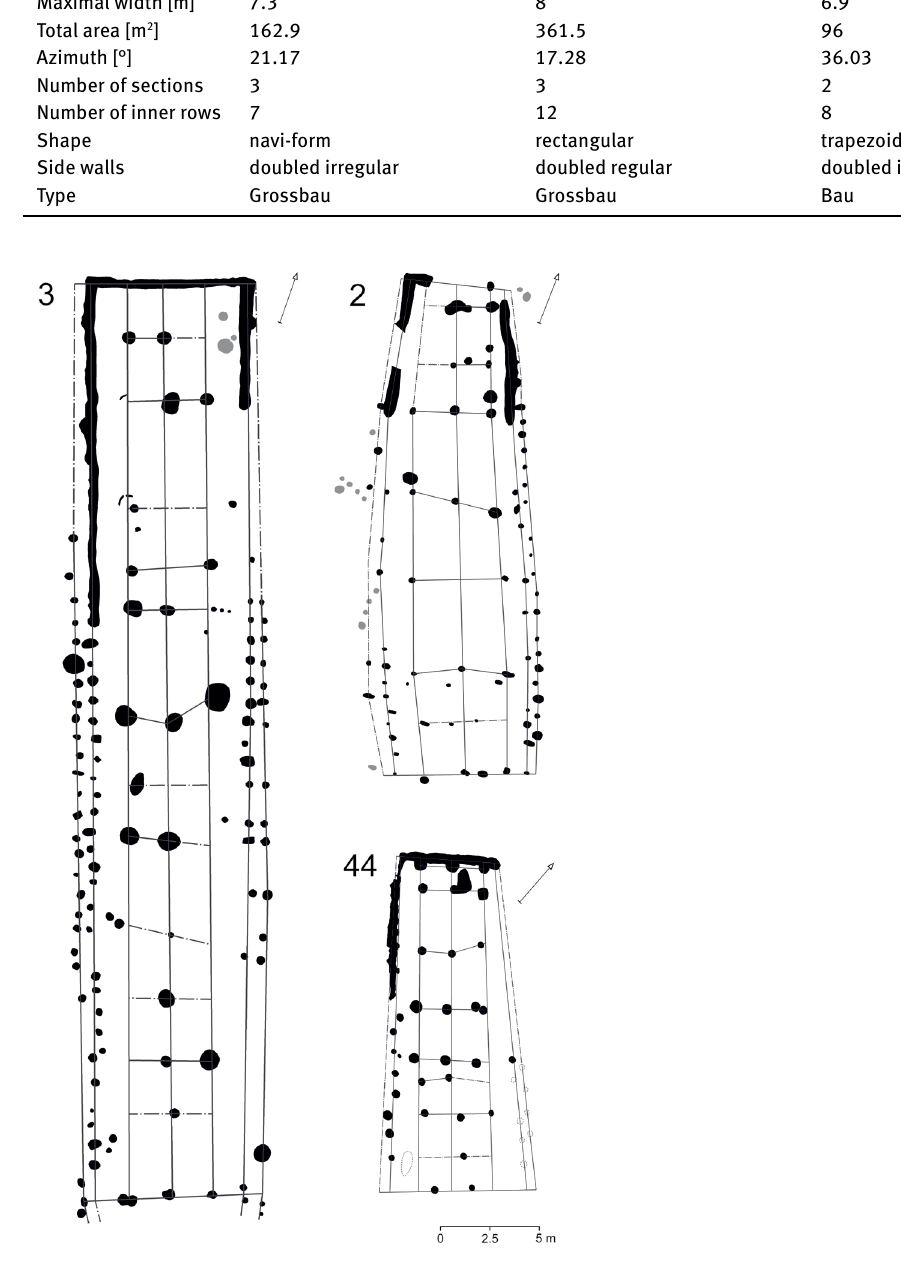
Figure 14. Longhouse ground plans of the F and G settlement horizons at